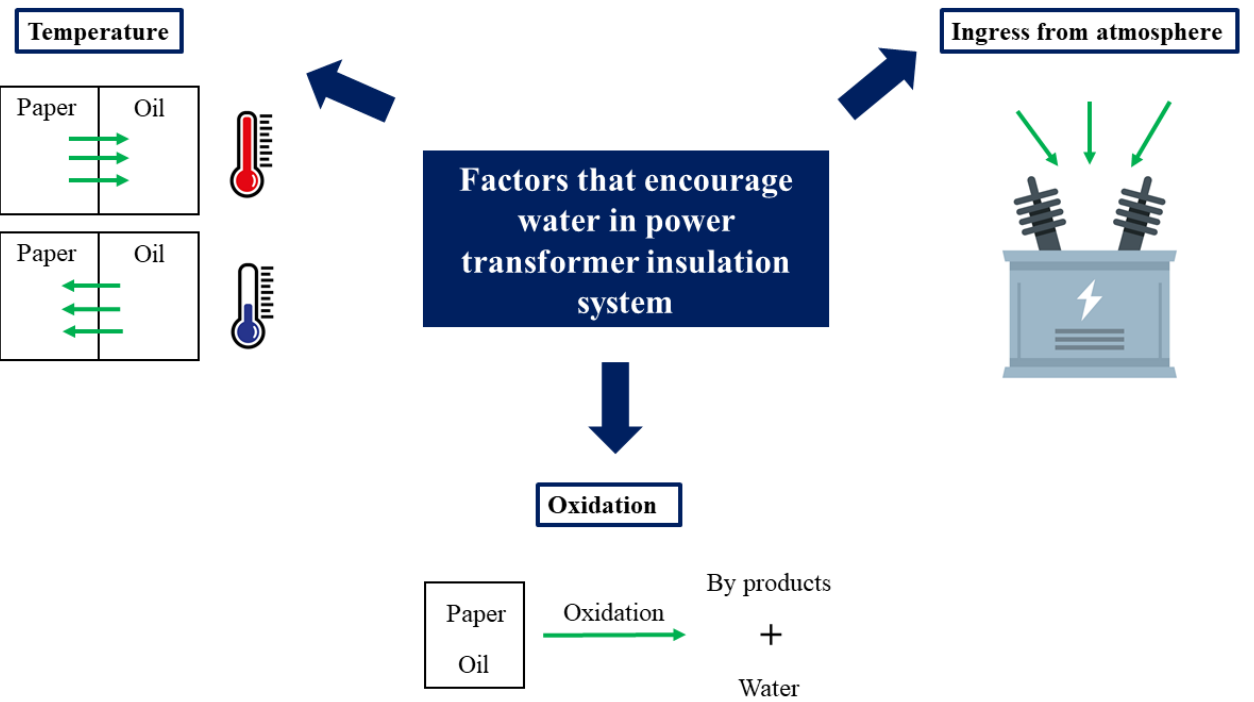
Figure 2. Factors that encourage water into transformer insulation system.